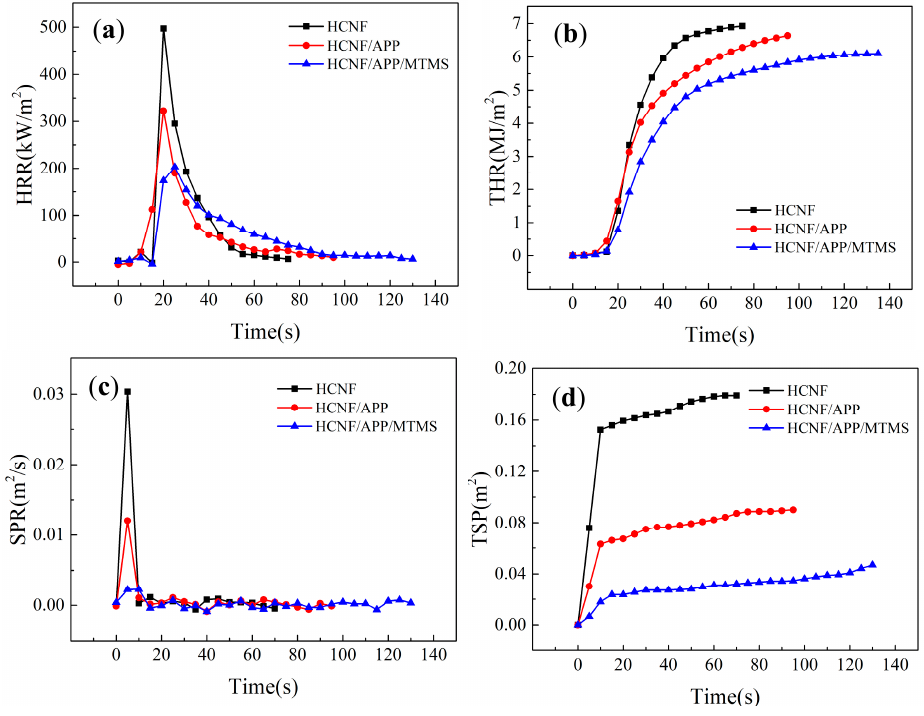
Figure 10. The ( a ) HRR, ( b ) THR, ( c ) SPR, and ( d ) TSP curves of the HCNF, HCNF/APP, and HCNF/APP/MTMS aerogels.